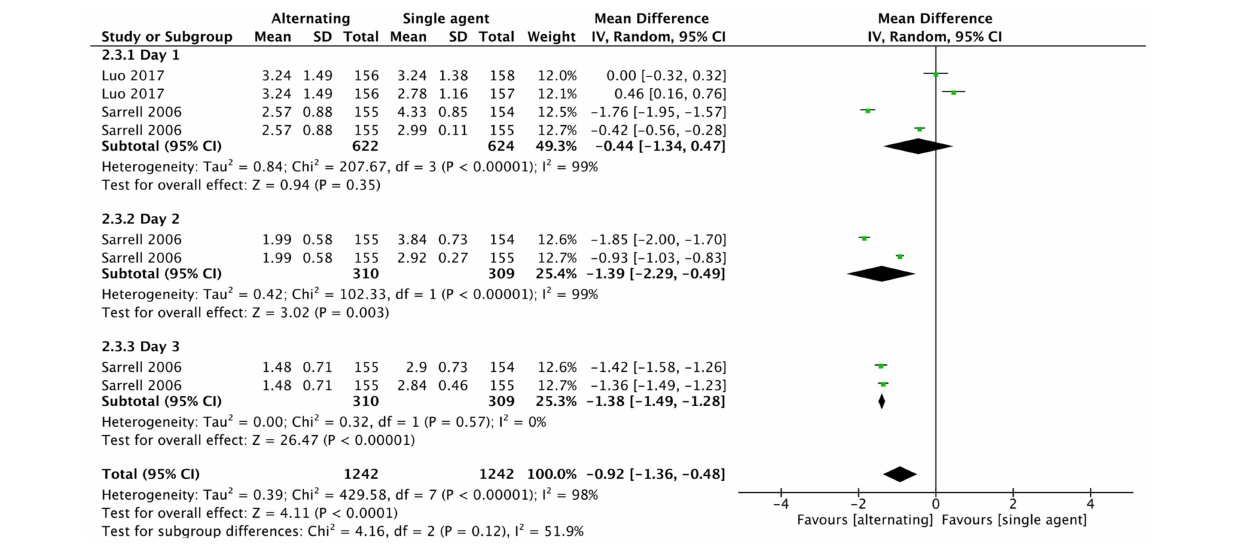
FIGURE 8 | Comparison: alternating vs. single agent, Outcome: doses of medication per child.